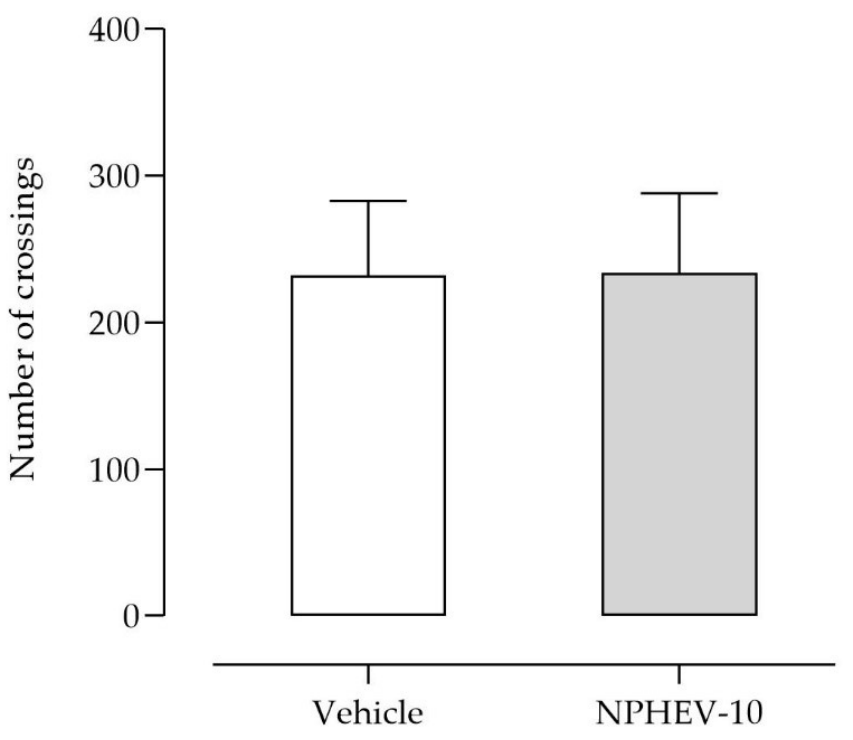
Figure 5. Spontaneous locomotor profile in the open-field test after the NPHEV-10 (25 mg/kg) administration. Data were tested using ordinary one-way ANOVA ( p > 0.05) .